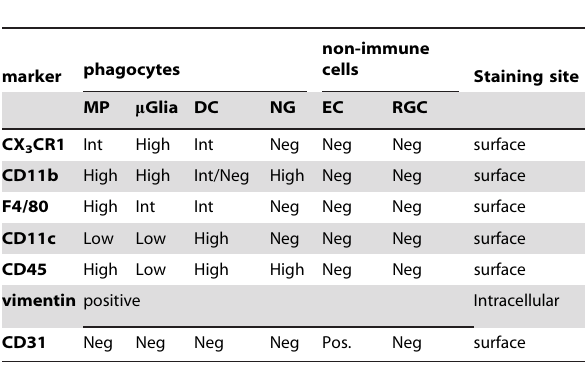
Table 1. Classification of VEGF + retinal/choroidal cells by intracellular and cell surface